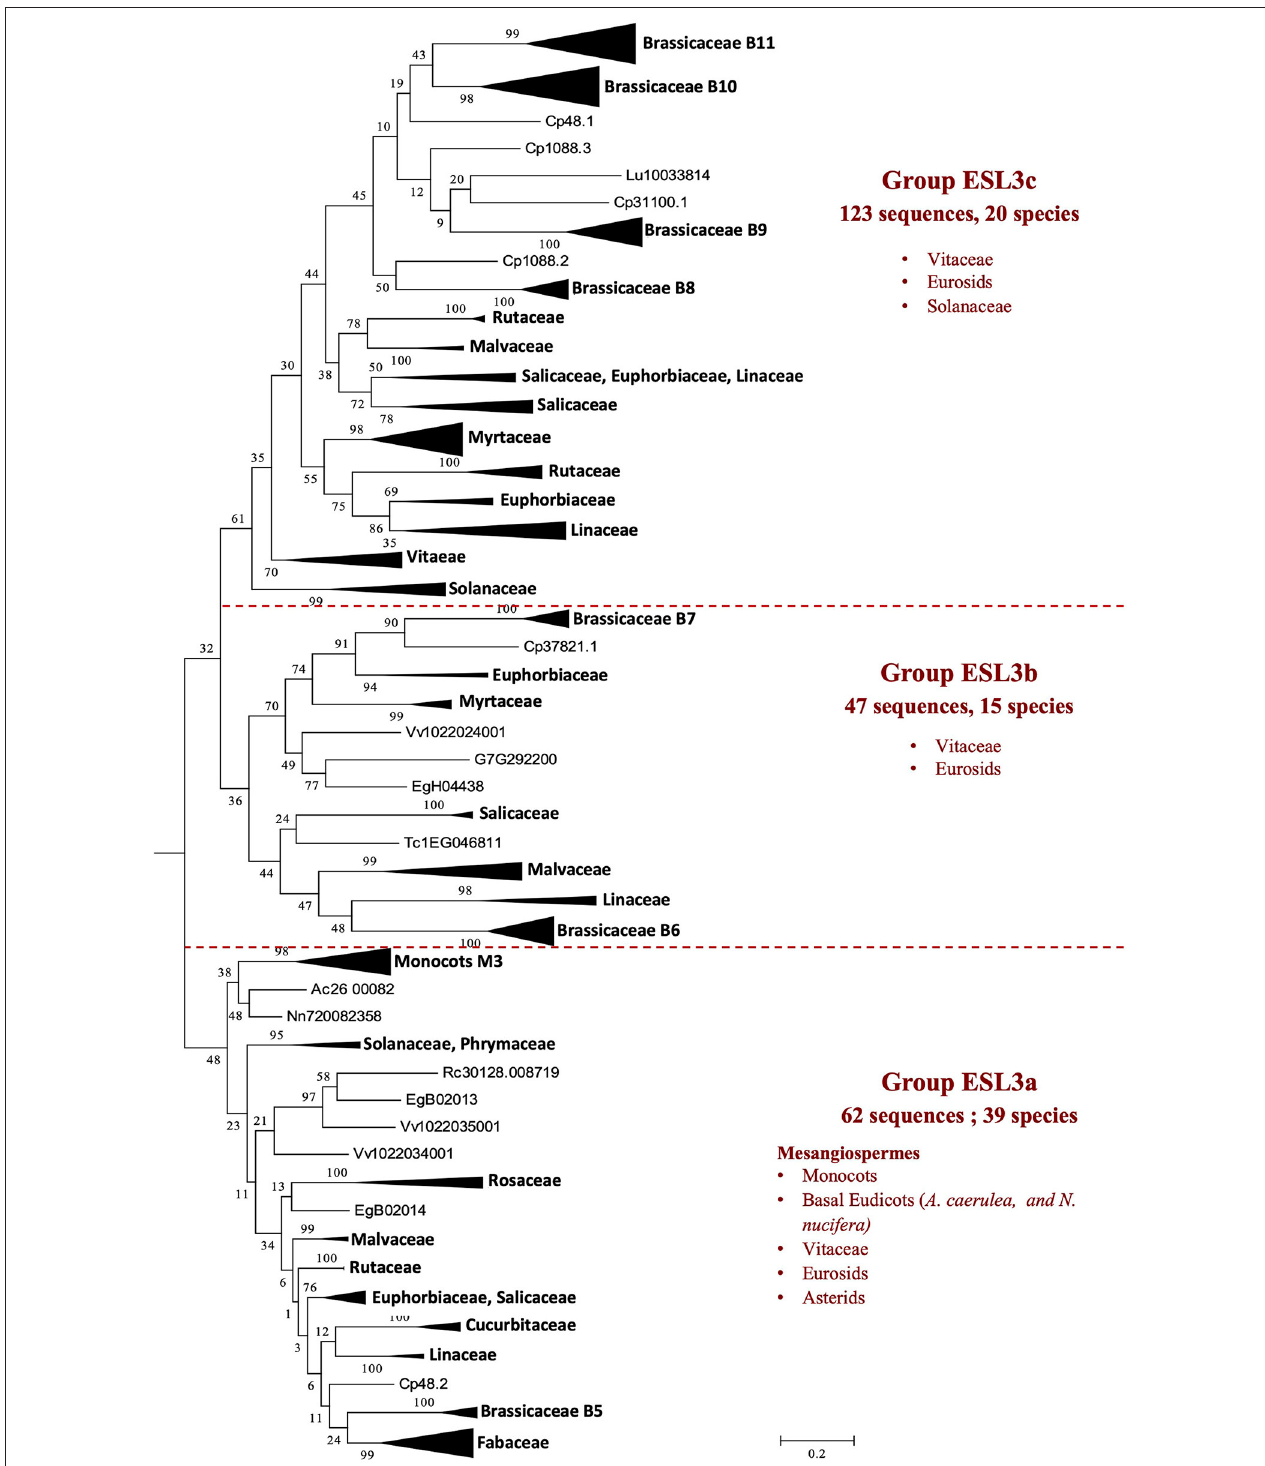
FIGURE 5 | The maximum likelihood phylogeny of ESL sugar transporter proteins: the details of group ESL3. The tree was produced by aligning 519 amino acid ESL sequences identified in 47 Embryophyta using ClustalW and was then built using the software Molecular Evolutionary Genetics Analysis (MEGAv6, Tamura et al., 2013). JTT amino acid substitution model was used, and the bootstrap consensus tree was inferred from 1,000 replicates. The percentage of replicate trees, in which the associated taxa clustered together in the bootstrap test is shown next to the branches. The tree is drawn to scale, with branch lengths measured in the number of substitutions per site. For the annotation of sequences, see Supplementary Table 1